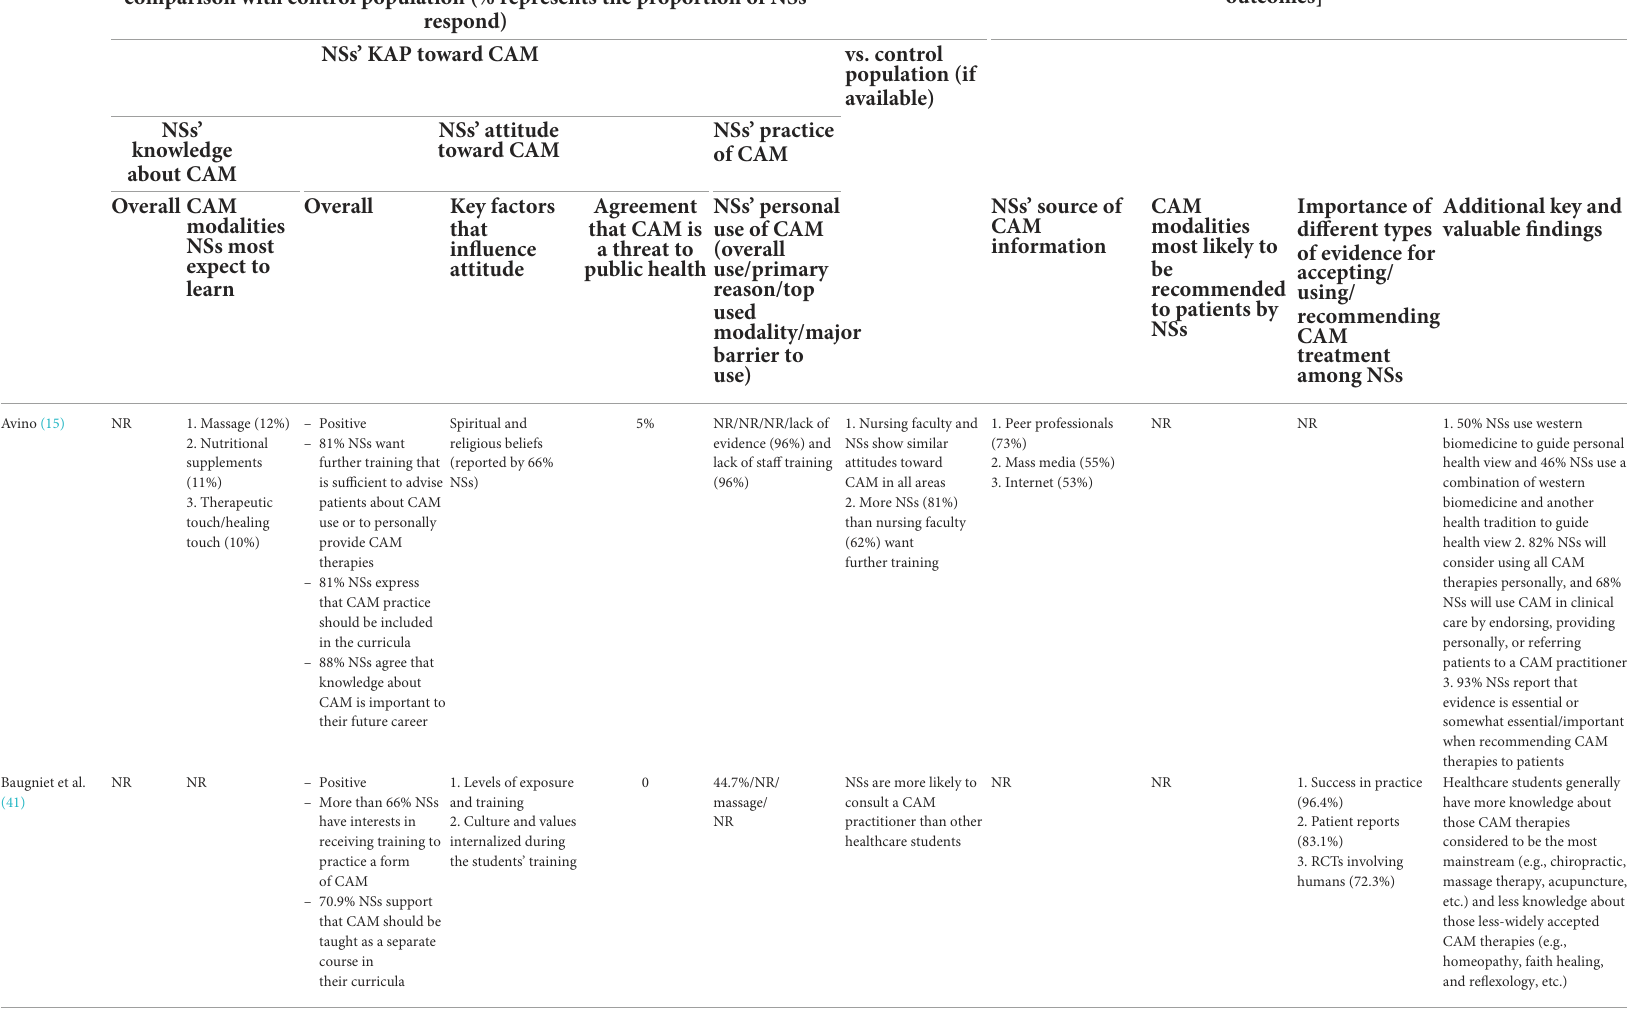
TABLE 3 NSs’ knowledge, attitude, use, barriers to use, recommendation, and source of information toward CAM